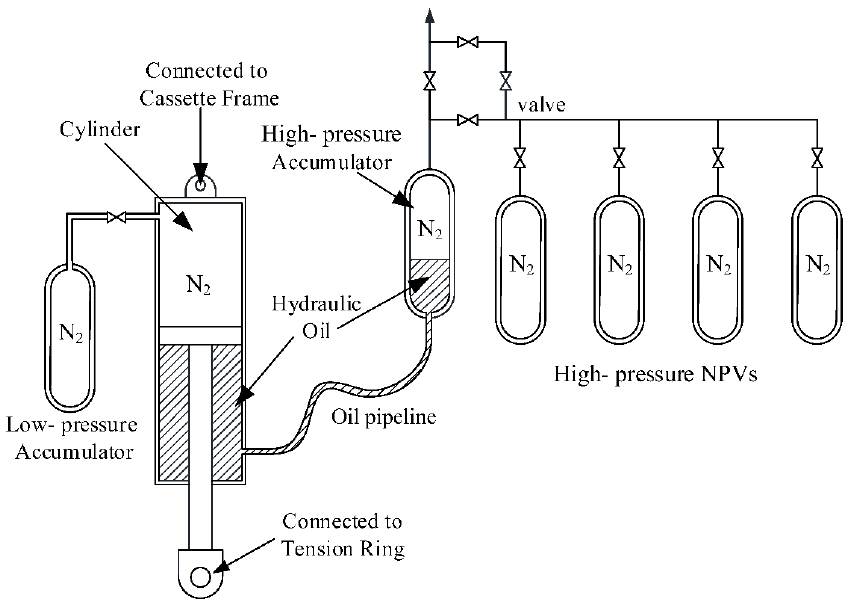
Figure 2. Schematic of the HPT.